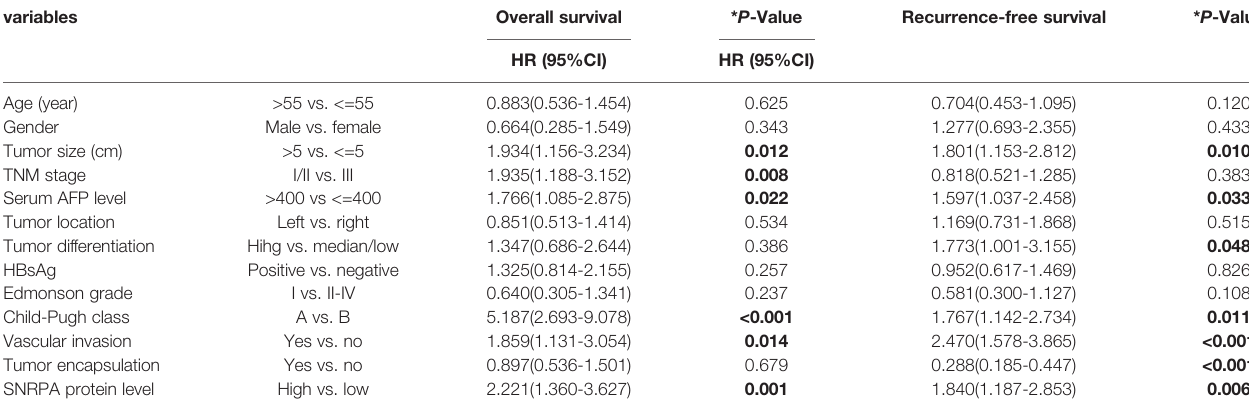
TABLE 2 | Univariate Cox Regression analysis of overall survival and recurrence-free survival in 161 patients with hepatocellular carcinoma. variables Overall